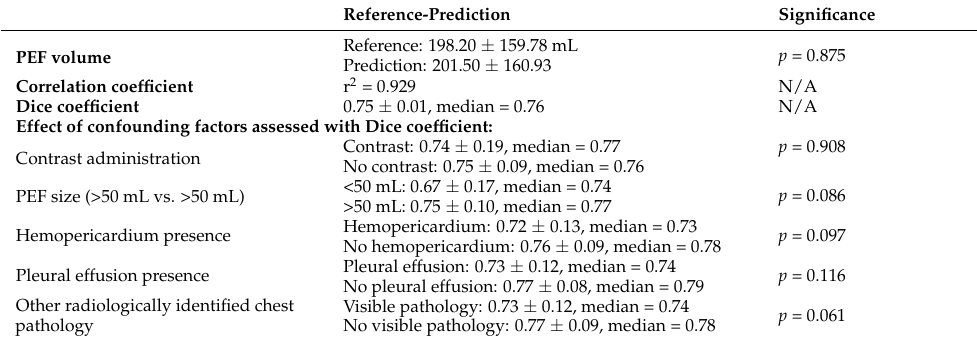
Table 4. Model performance and the effect of confounding factors.